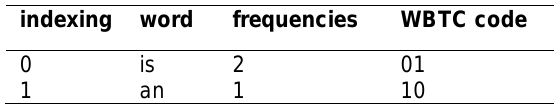
Table 6: Word-frequency table for length two